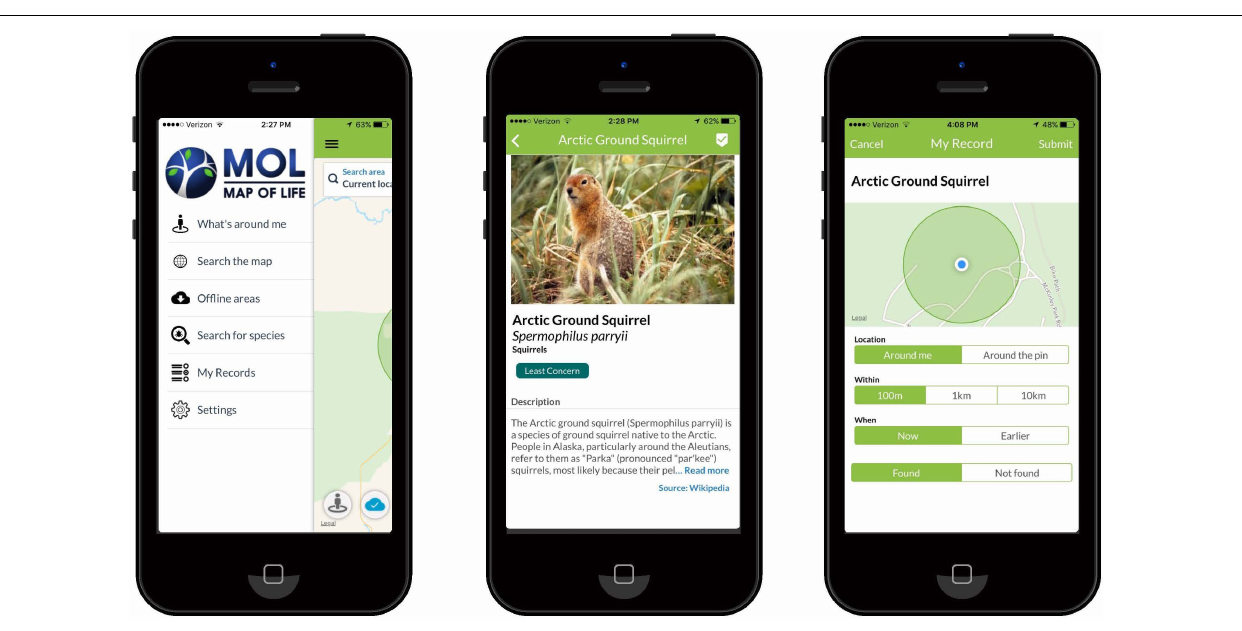
Frontiers in Ecology and Evolution |